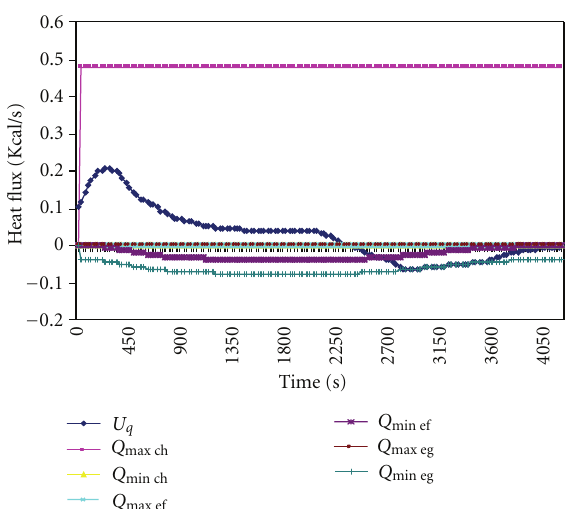
Figure 9: Evolution of thermal flux and limits thermal flux, K = 1, K r = 0.5.